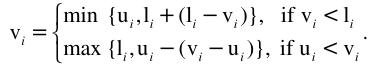
where x ∈ R d , f: R d → R is the function to be optimized, g R is the j-th inequality function, and h function. The i-th component of x : x